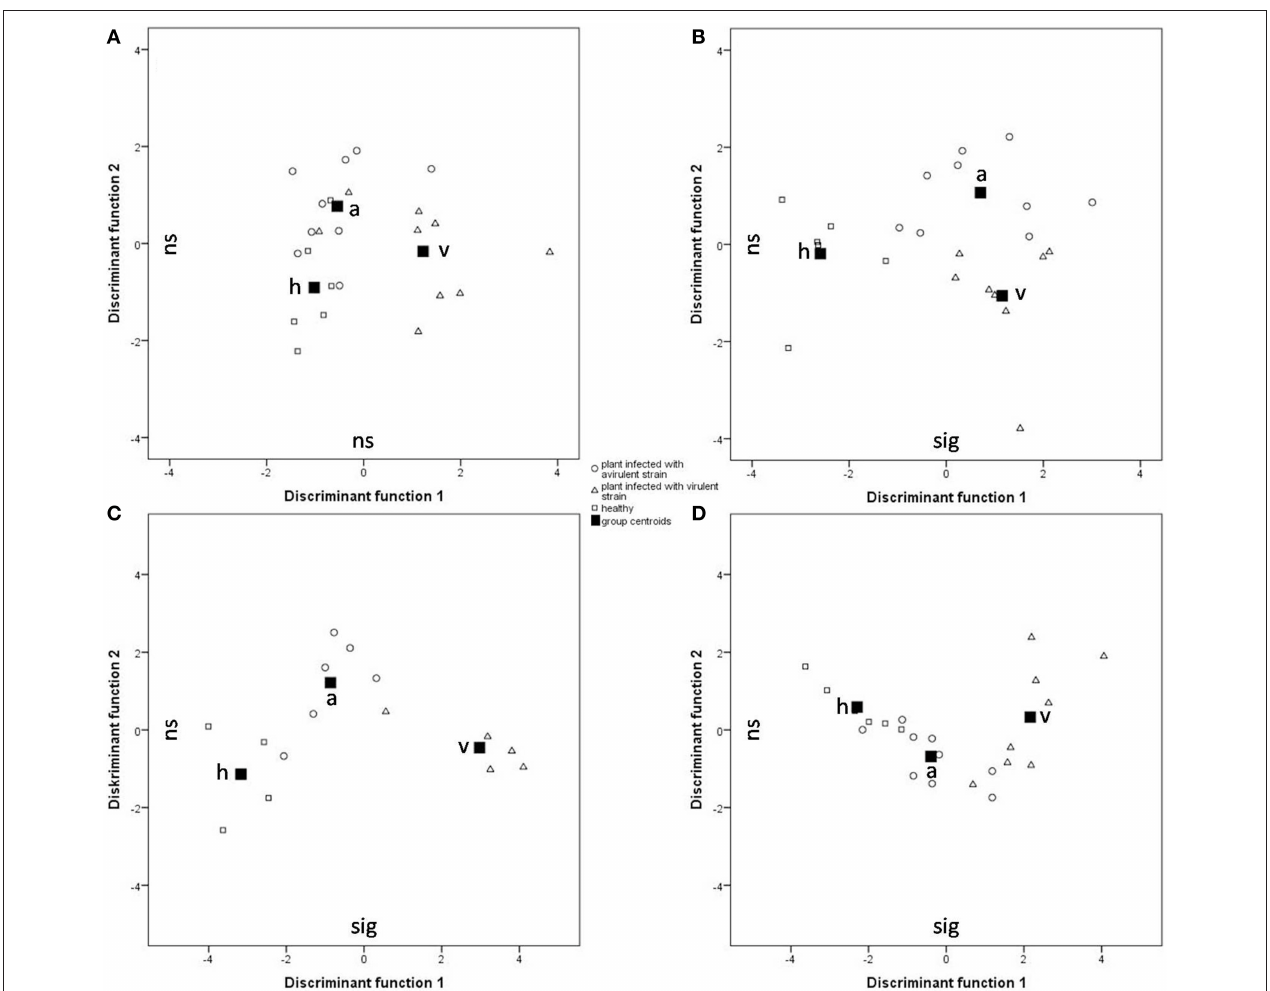
FIGURE 3 | Comparison of the odor composition of tobacco plants’ headspace according Ca. P. mali infection conditions using a DFA. Group centroids are depicted as squares. h, healthy plants (squares); a, tobacco plants infected by the avirulent strain (circles); v, tobacco plants infected by the virulent strain (triangles). (A) 8 weeks after grafting ( N h = 6, N a = 9, N v = 9; discriminant function (df) 1: ns, df 2: ns); (B) 10 weeks after grafting ( N h = 6, N a = 8, N v = 9; df 1: sig, df 2: ns); (C) 11 weeks after grafting ( N h = 4, N a = 6, N v = 6; df 1: sig, df 2: ns); (D) 12 weeks after grafting ( N h = 6, N a = 9, N v = 8; df 1: sig, df 2: